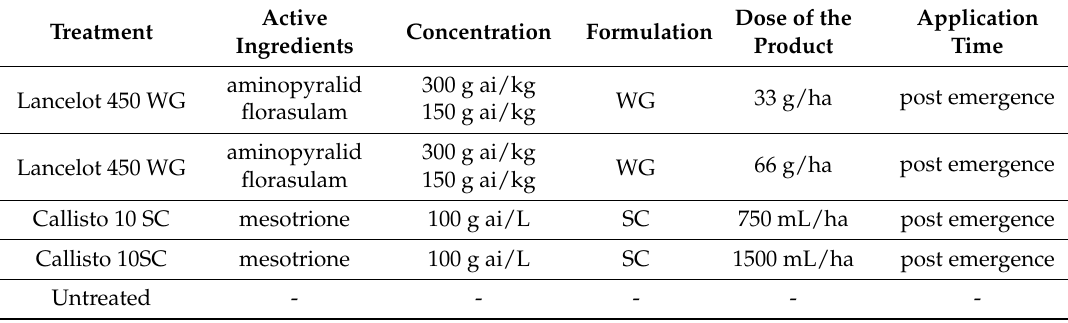
Table 2. Treatments applied in the field experiments. Commercial names of the products, active ingredients, formulations and doses are given.